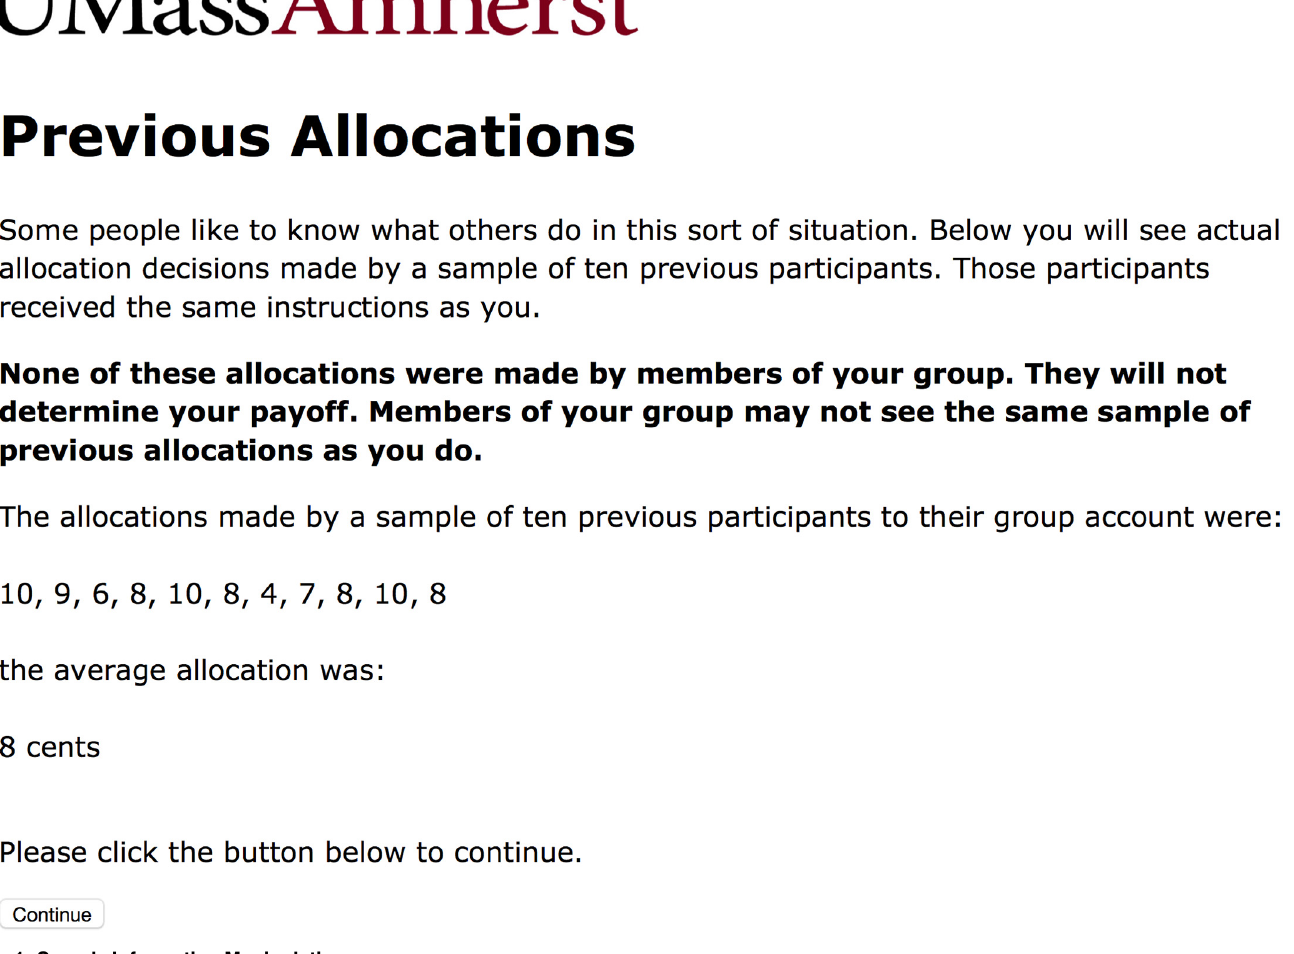
Fig 1. Sample Information